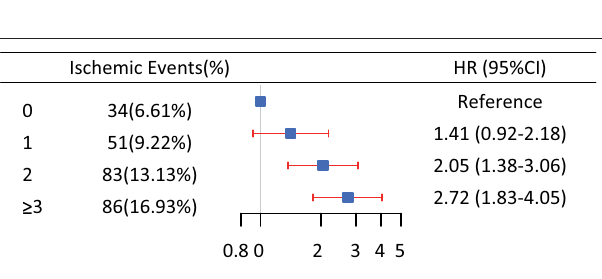
risk-score, were 553 (25.1%), 632 (28.6%), and 508(23.0%), respectively. The overall distribution of incremental risk-score categories was displayed in Supplementary Figure S2 . The baseline demographics and calculation of risk scores are reported in Table 1 . The antiplatelet therapy during the follow-up period